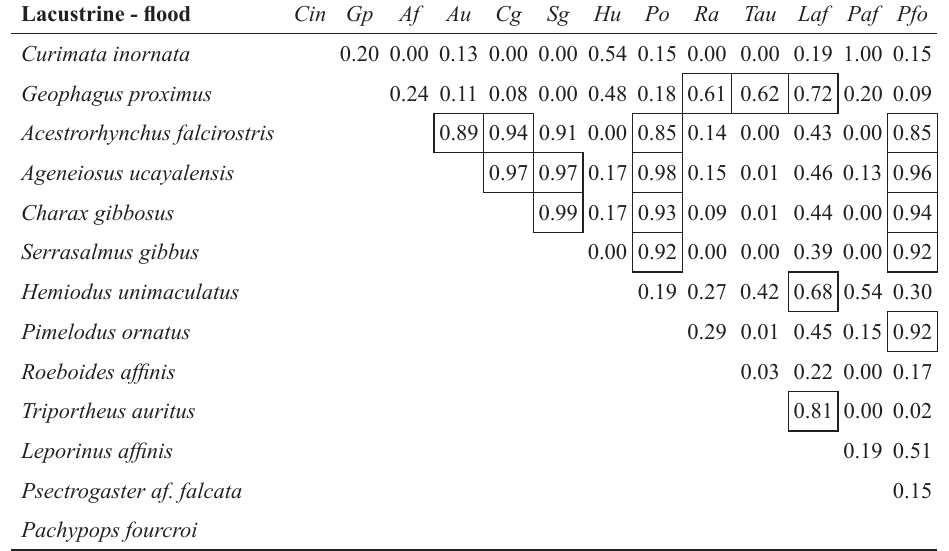
Niche overlap between pairs of species analyzed from Lacustrine area of Coaracy Nunes Dam, Ferreira Gomes – Amapá